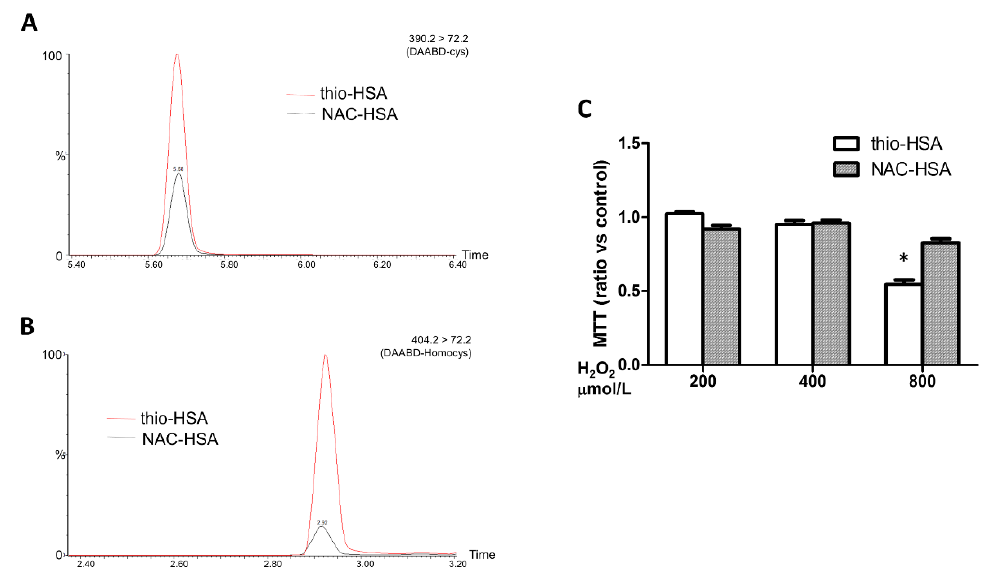
Figure 4. Biological effects of S-thiolated albumin. ( A , B ) Effects of NAC treatment on the levels of low-molecular-weight thiols bound to HSA. Representative chromatograms of the analysis of low-molecular-weight thiols bound to HSA after derivatization with DAABD-Cl are shown in panel A for cysteine bound to HSA (DAABD-cys) and in panel B for homocysteine bound to HSA (DAABD-homocys). ( C ) Cell viability of HL-1 cells pretreated with thio-HSA or NAC-HSA and subsequently treated with H 2 O 2 at different concentrations for 7 h.* p > 0.05 by two-way ANOVA.